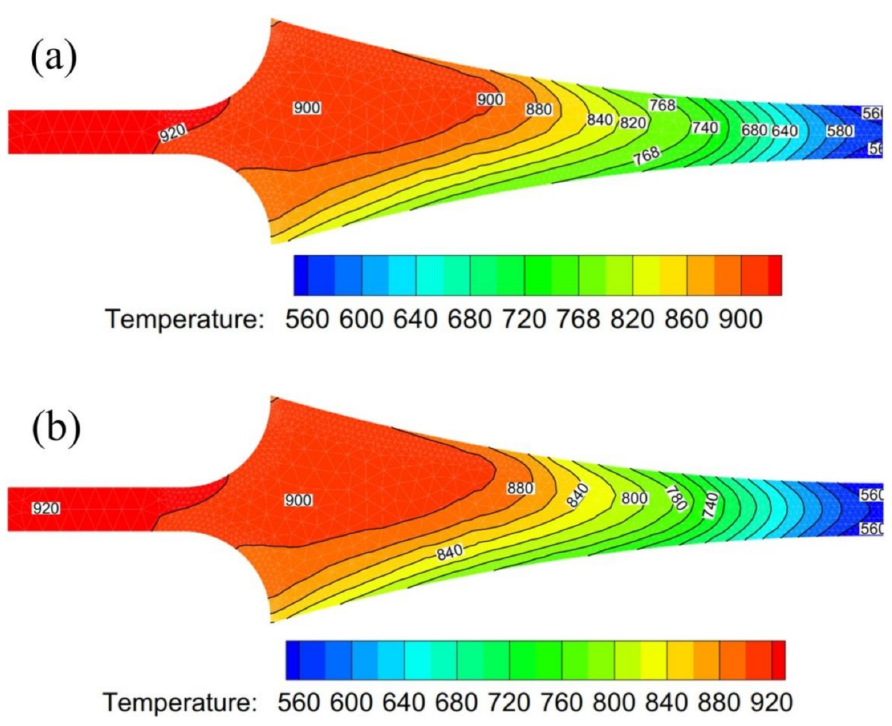
Figure 9. The temperature field in the TRC and electromagnetic TRC process: ( a ) TRC; ( b ) electro- magnetic